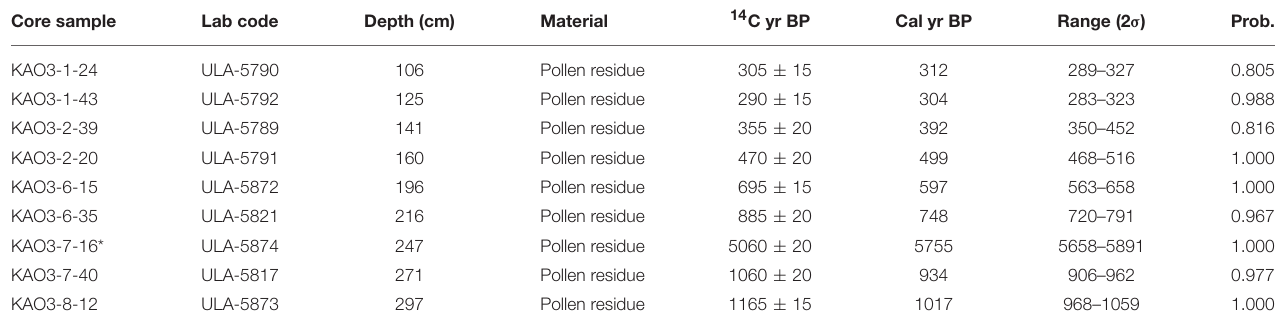
TABLE 1 | Results of radiocarbon dating carried out at the Radiochronology Lab of the Université Laval (Canada). Core sample